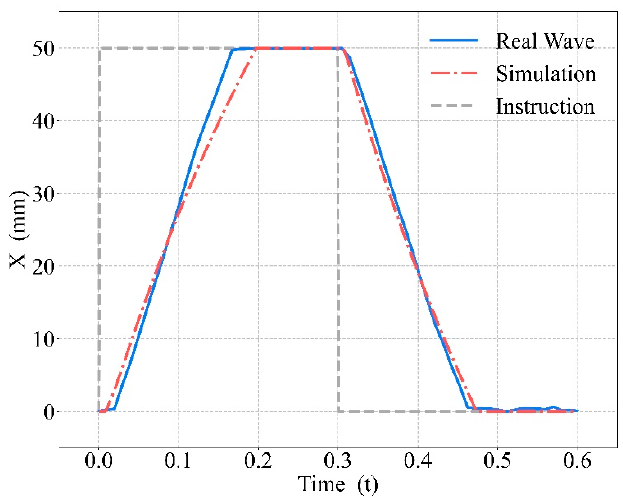
Figure 8. Mechanical waveform, simulated waveform, and the instruction signal. Table 1. Piston movement characteristics (real wave vs. simulation).